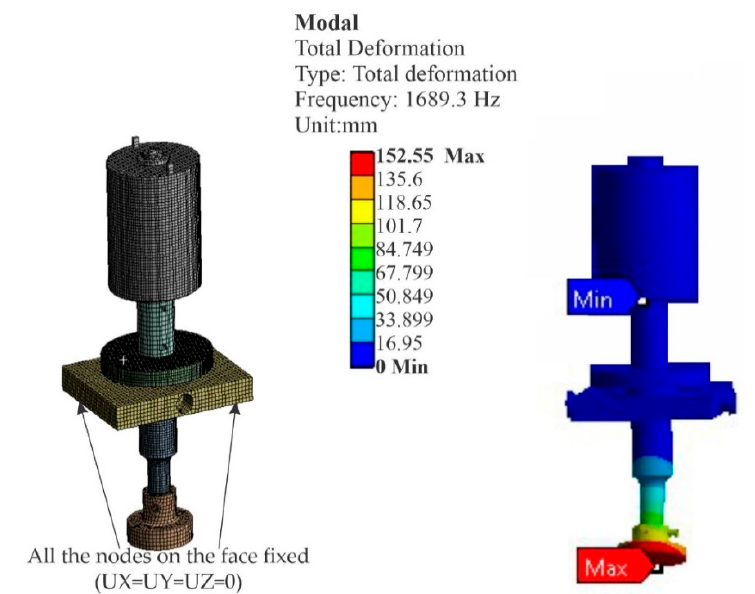
Figure 6. Total deformation of the rotor.